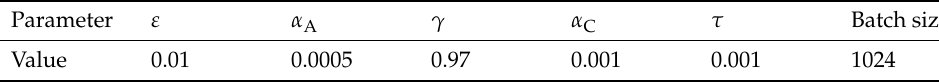
Table 1. Main parameter configuration of MADDPG.